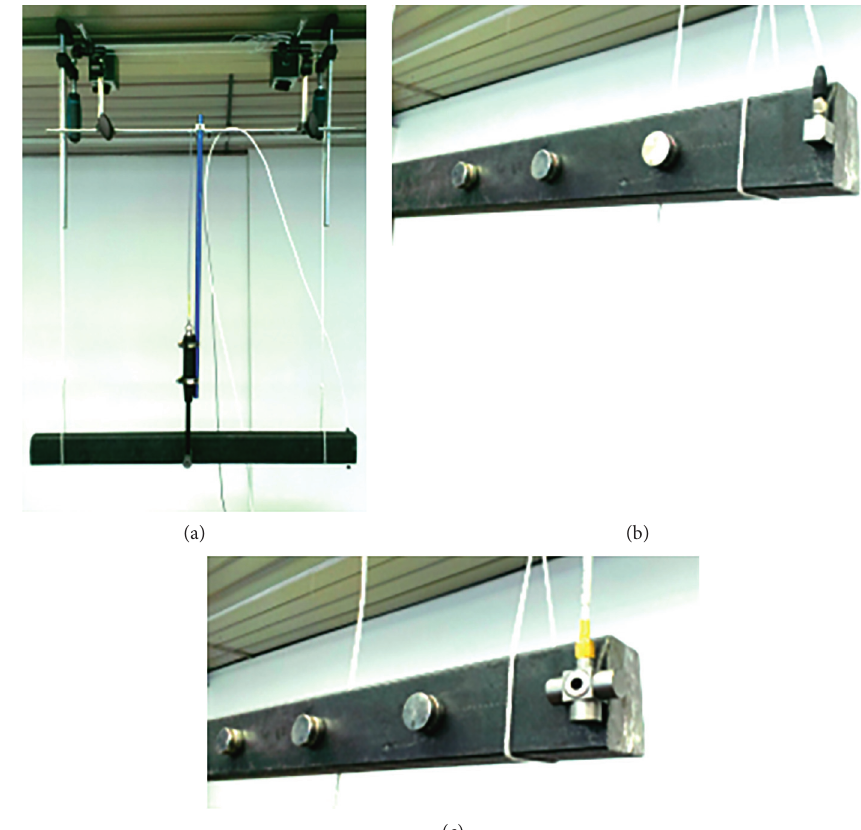
Figure 10: Dynamic response test device of steel beam [99].